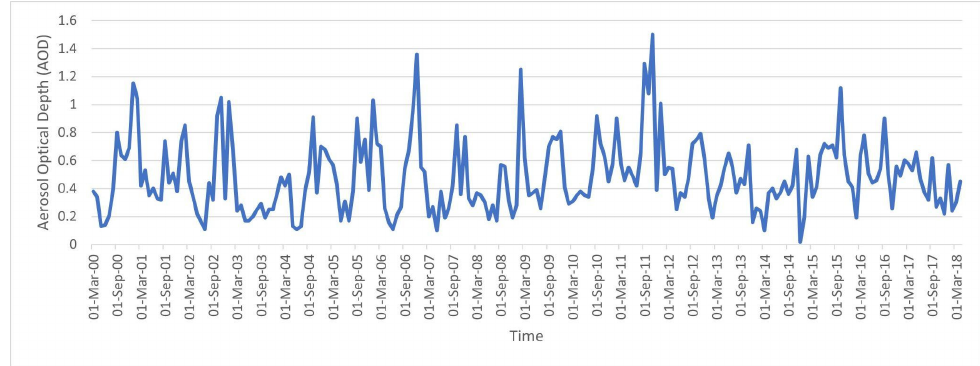
Figure 3. The aerosol optical depth distribution over Narrabri over 15 years estimated by the atmosphere global product based on Modis MOD08_M3 V6.